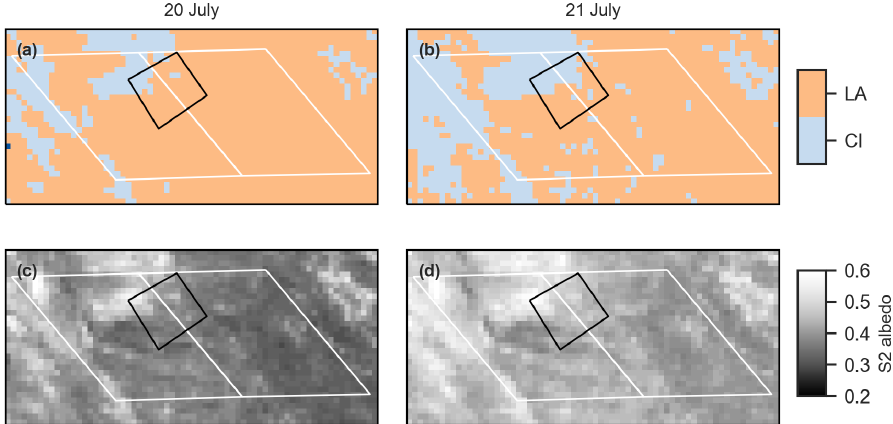
Figure 6. Observations from S-2 in UAS and MODIS areas. (a, b) Surface type classification from S-2. (c, d) Albedo from S-2. (a, c) 20 July and (b, d) 21 July. White rectangles indicate 500m MODIS sinusoidal grid pixels covering study area; black rectangles indicate UAS study area.